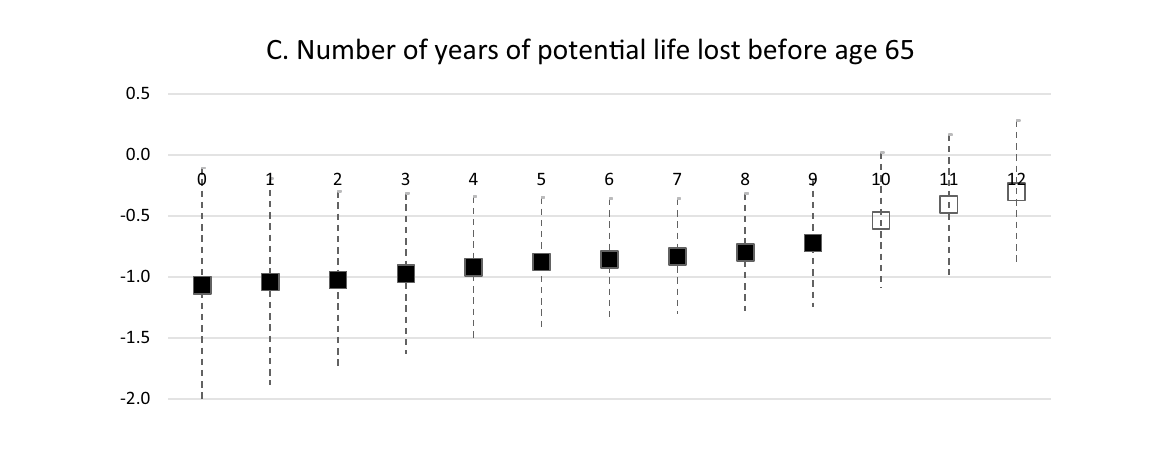
Fig. 3 Estimates of β k from 2-way fixed-effects premature mortality models [Eq. (3)] Solid squares denote significant ( p value < .05) estimates; hollow squares denote insignificant